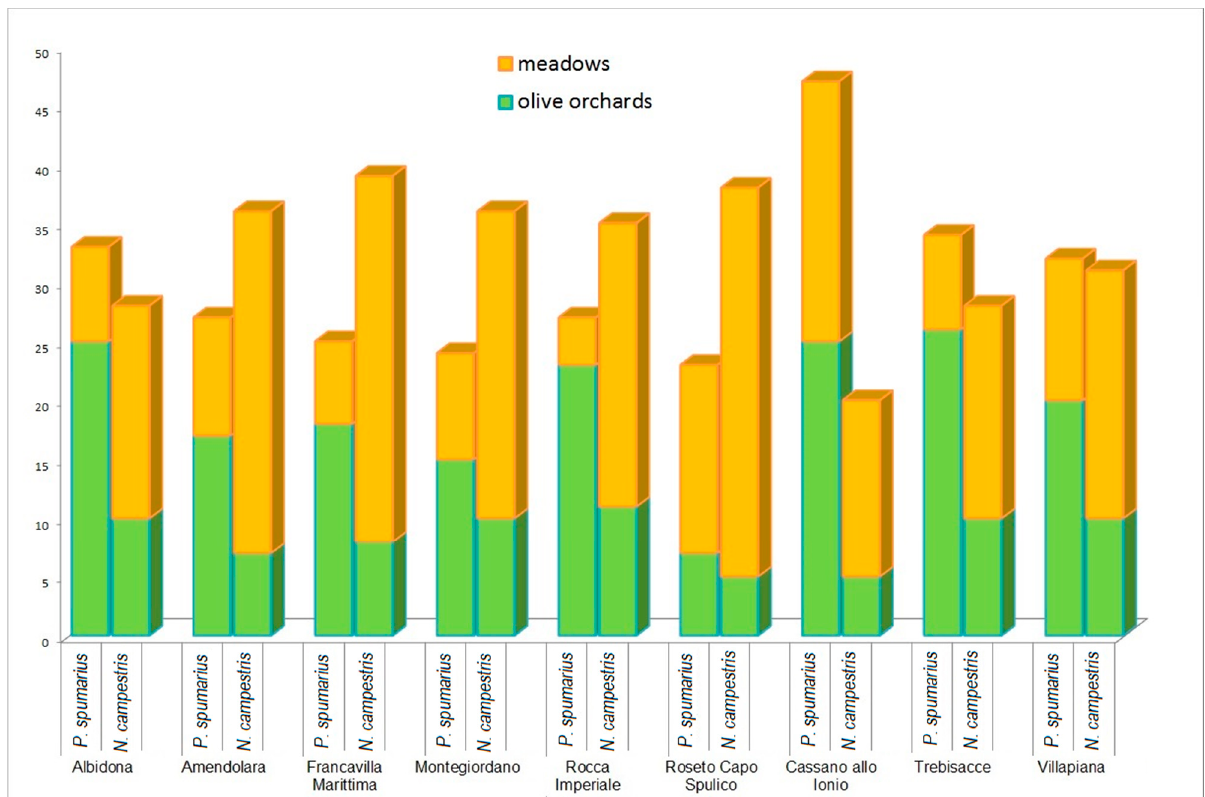
Figure 3. Abundance and distribution of P. spumarius and N. campestris throughout the sampling areas (municipalities).